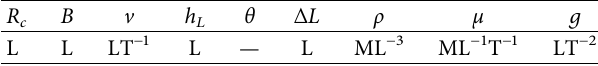
Table 3: Dimension of each parameter of dimensional analysis